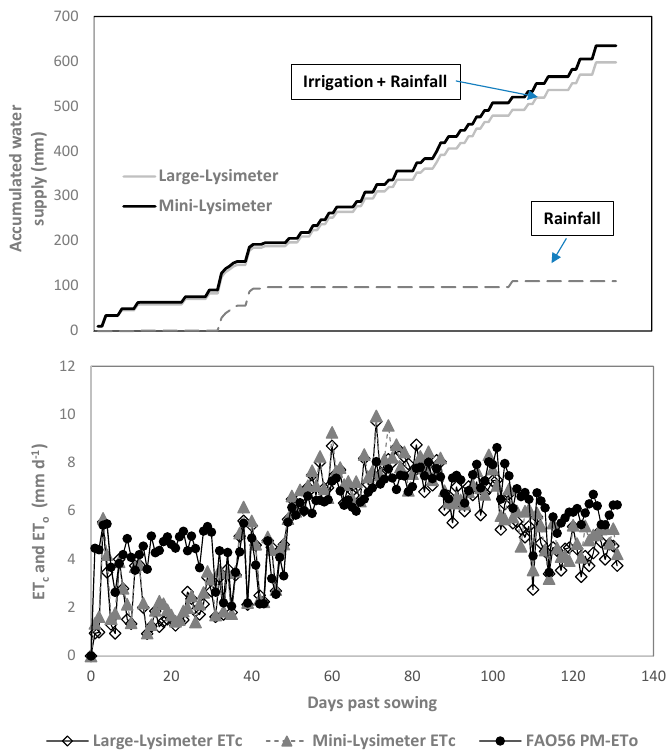
Figure 5. Seasonal rainfall and total water supply to each lysimeter for potato ( top ). Daily ET c values for potato from each weighing lysimeter and the computed grass FAO56 PM-ET o from daily weather data ( bottom ).